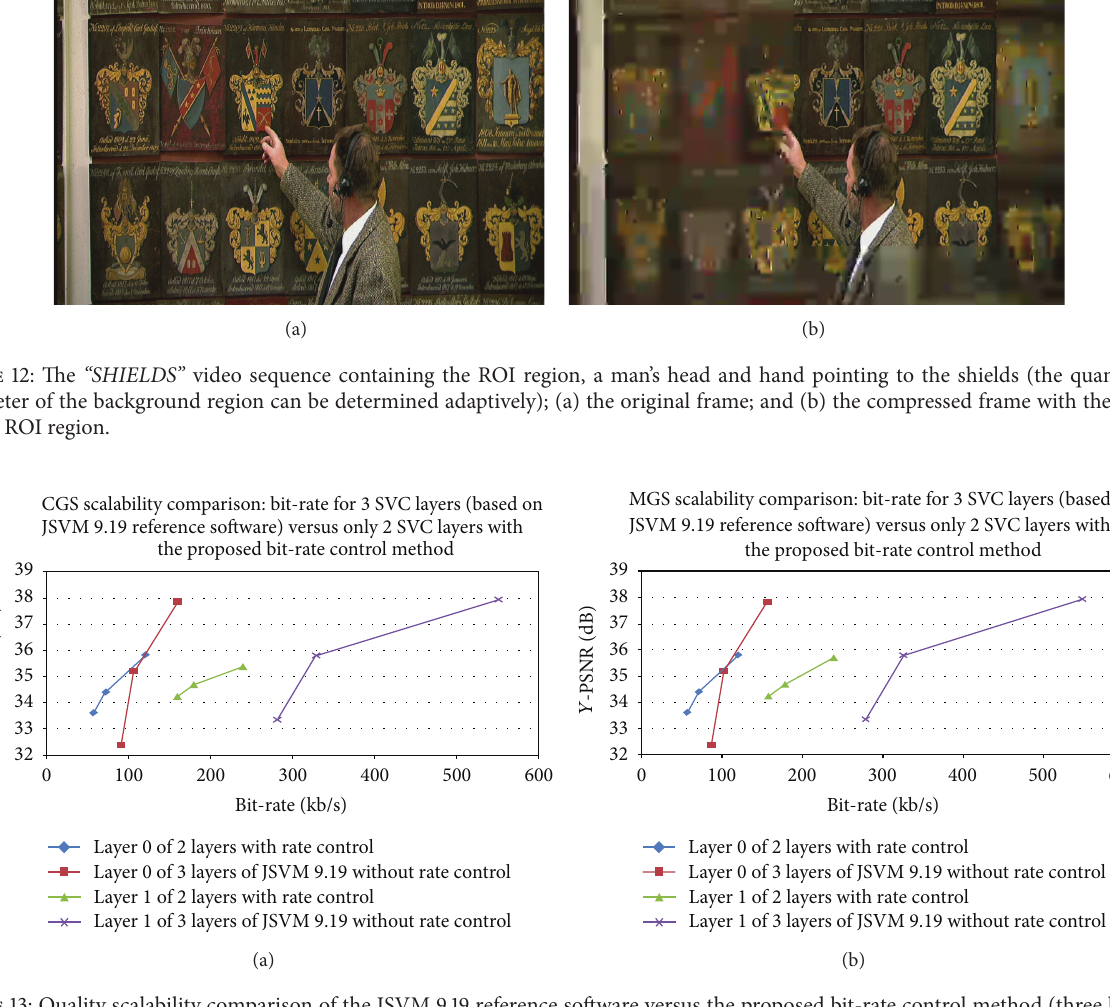
Figure 13: Quality scalability comparison of the JSVM 9.19 reference software versus the proposed bit-rate control method (three layers of JSVM 9.19 versus two layers of the proposed rate control scheme; “STOCKHOLM ” video sequence). The QP values for each layer are 30, 35, and 40. (a) CGS comparison; and (b) MGS